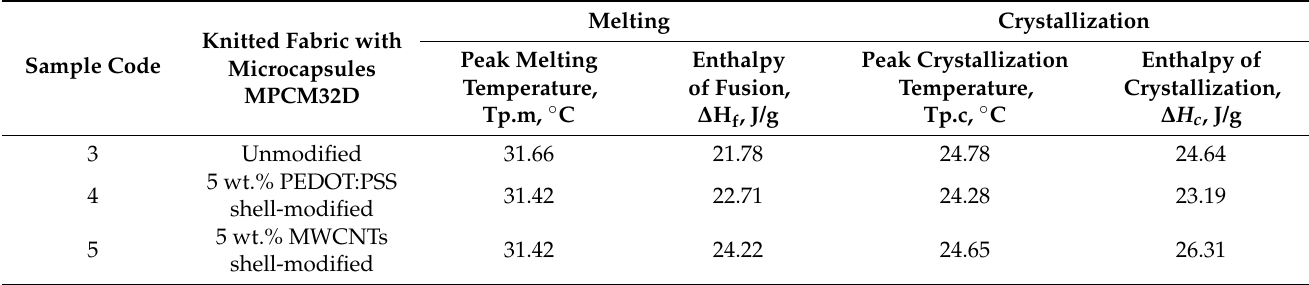
Table 5. DSC analysis results of 3D warp-knitted PET fabric with unmodified and shell-modified microcapsules MPCM32D.